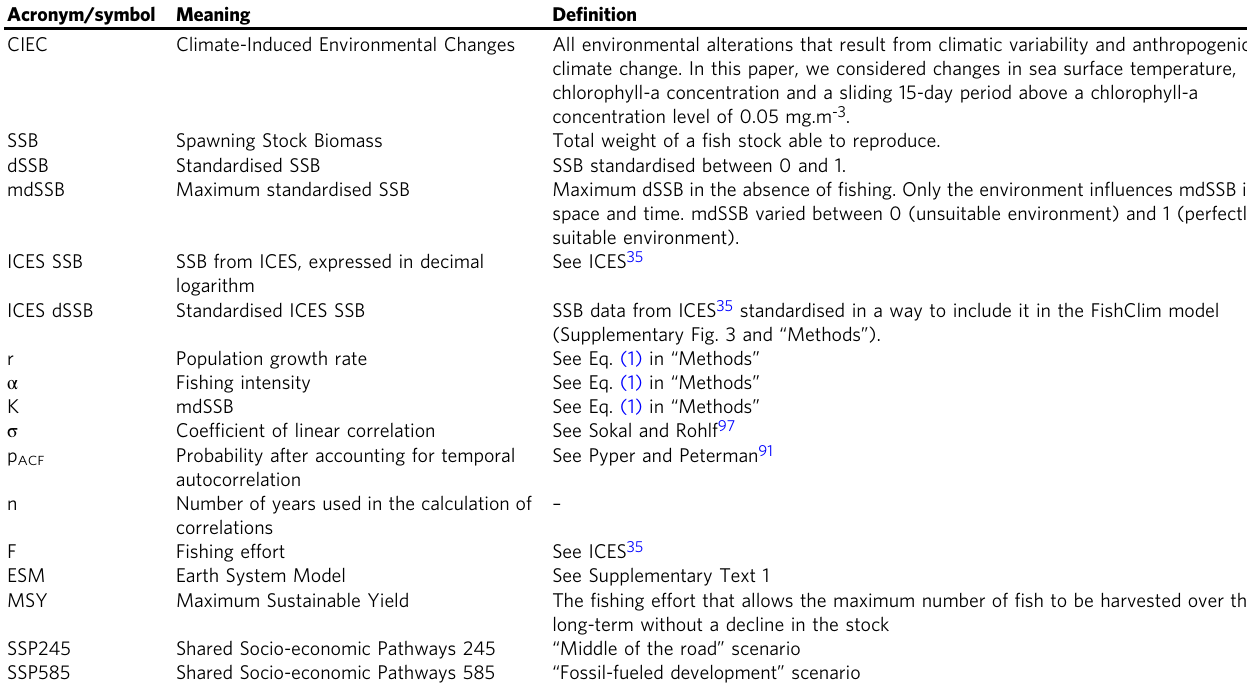
Table 1 List of acronyms and main symbols used in the text. Other symbols can be found in the “ Methods ” section. Acronym/symbol